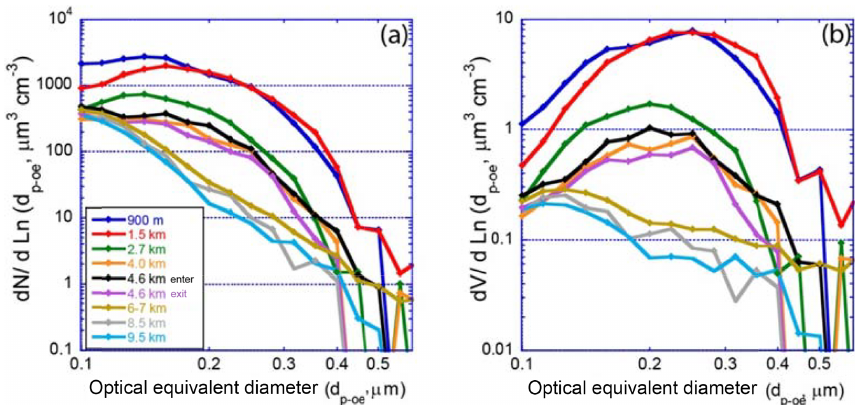
Figure 9. Laser aerosol spectrometer (a) number and (b) volume distributions of aerosol layers as a function of altitude. The legends for the two graphs are the